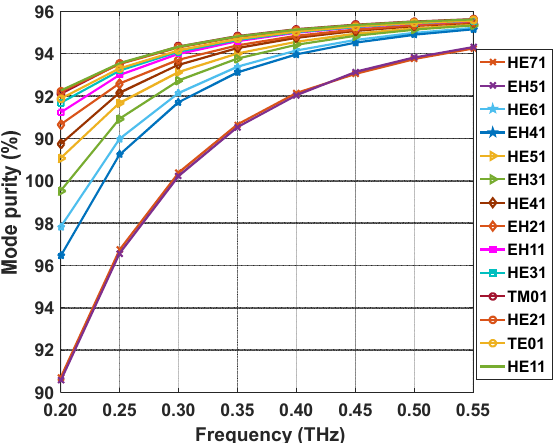
Figure 13. Mode purity as a function of frequency for different modes.